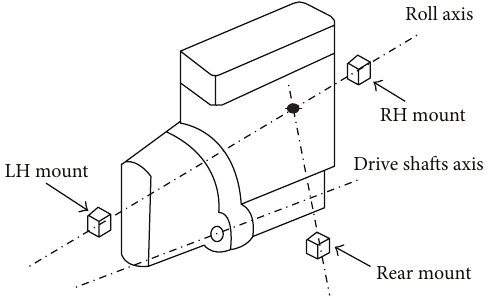
Figure 1: Transverse engine mounting system [7].